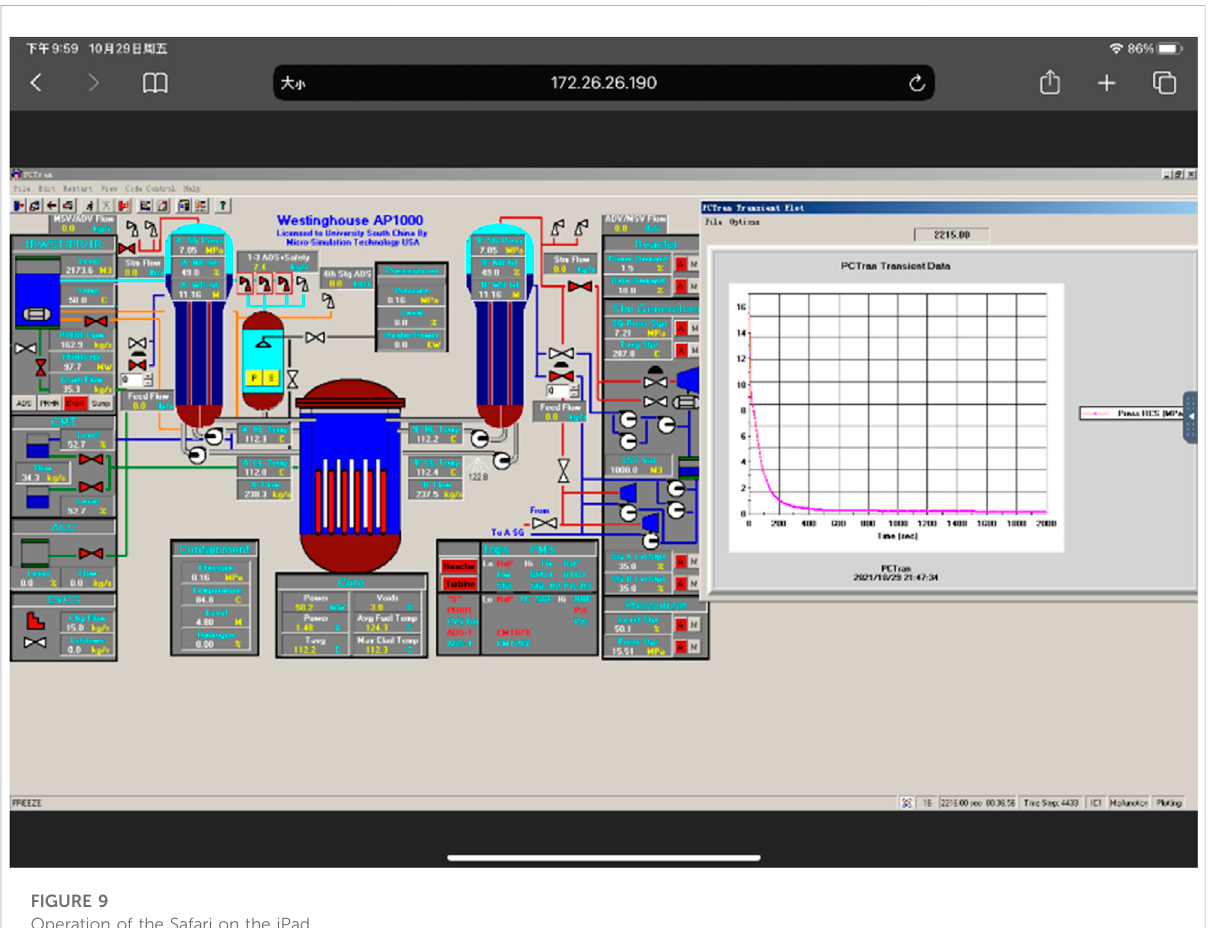
Operation of the Safari on the